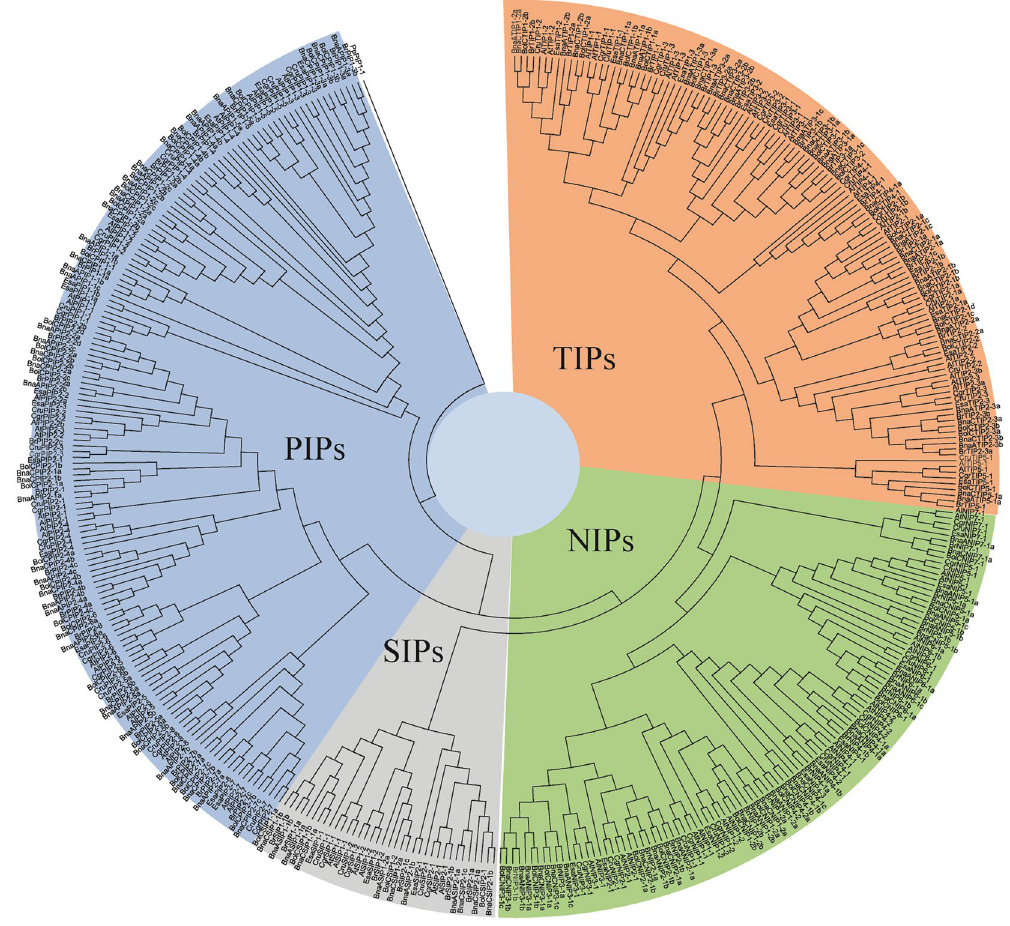
Figure 2. Phylogenetic tree of aquaporins identified in seven Brassicaceae species along with the previously reported aquaporins in Arabidopsis thaliana . Aquaporins are denoted with the abbreviation of species name as At - Arabidopsis thaliana , Al - Arabidopsis lyrata , Cru - Capsella rubella , Cgr - Capsella grandiflora , Bra- Brassica rapa , Bna - Brassica napus , Bol - Brassica oleracea , Esa - Eutrema salsugineum